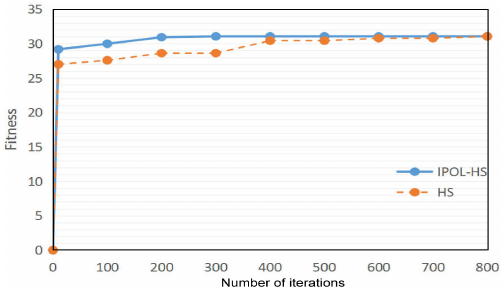
Fig. 8 Run time of different sizes of synthetic dataset. Fig. 9 Comparison of convergence on R1K.